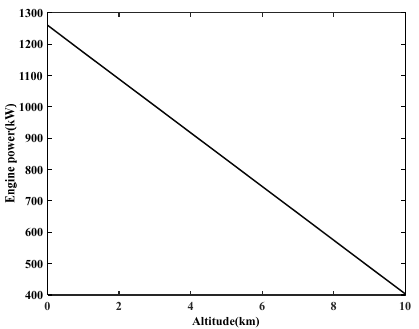
Figure 23. Altitude characteristics of a typical turboshaft engine.